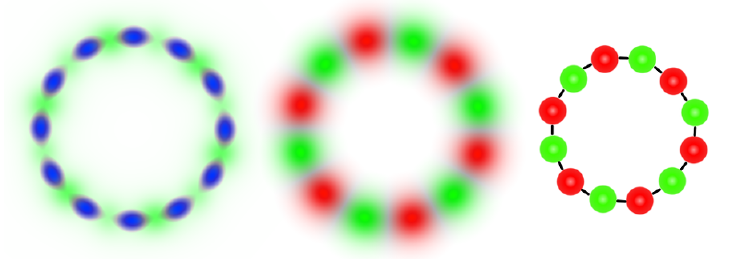
Figure 9 : ( Q 1 ; Q 2 ) = (2 ; 2) nonminimal vortex ring. The (cid:12)gure contains 3 elements from left to right: an energy density plot, a (cid:12)eld density plot and a sketch of how the red and green vortices are interconnected. The (cid:12)rst two plots are made using the coloring scheme of (cid:12)gure